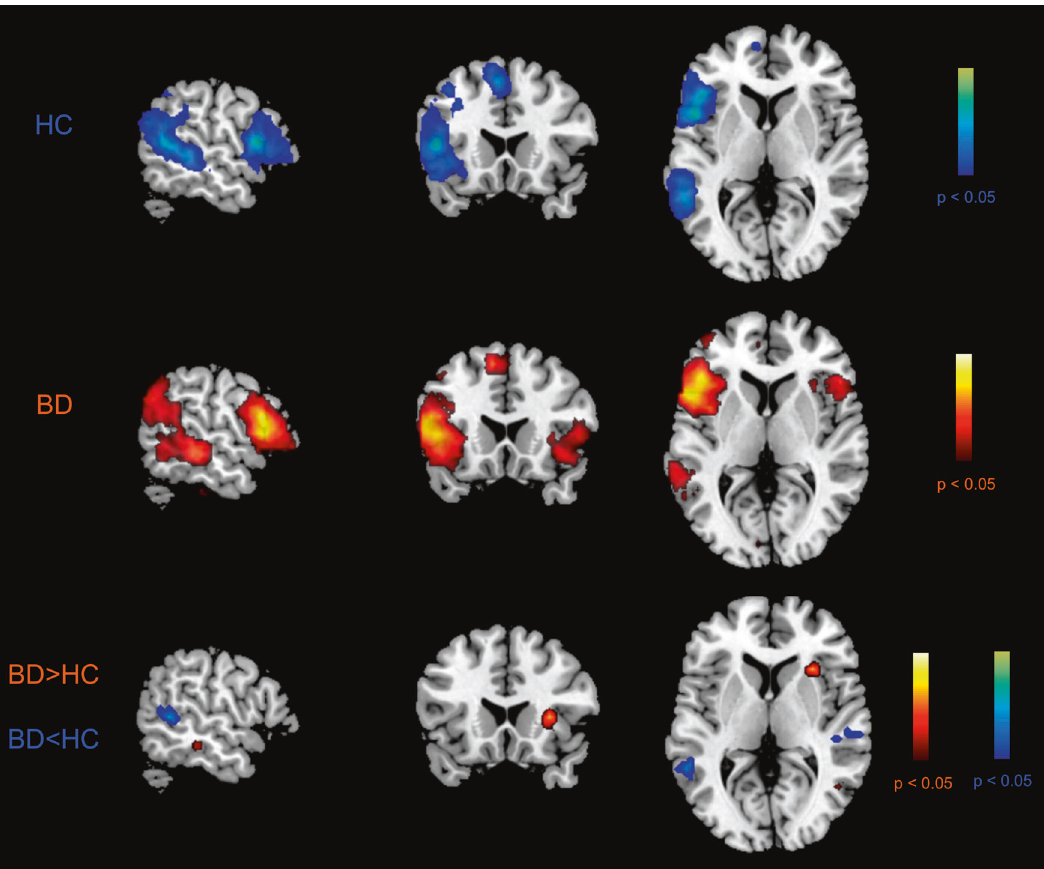
Fig. 1 LN maps in HC and BD patients and contrast between groups. Random-effects group-level t- maps of the LN in HC (top row, winter color scale) and BD patients (middle row, hot color scale), and the random-effects group-level t-map (all p s< 0.05, BH-FDR corrected) for the difference between HC and BD patients (bottom row, hot/winter color scales depending on the group contrast), which was masked to only show the signi fi cant differences between the two groups for the LN areas and their homologous. Other regions, apart from the LN, which showed between-group differences are reported in Supplementary Material (Figure